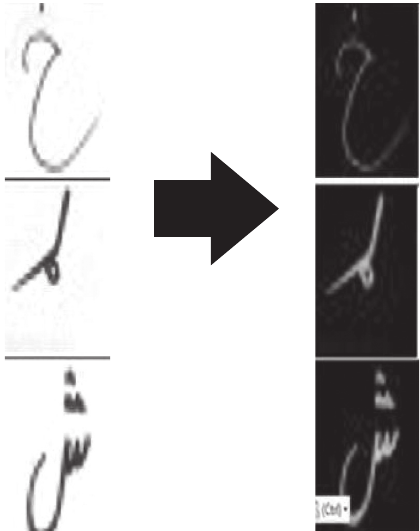
Figure 8: Actual character conversion.